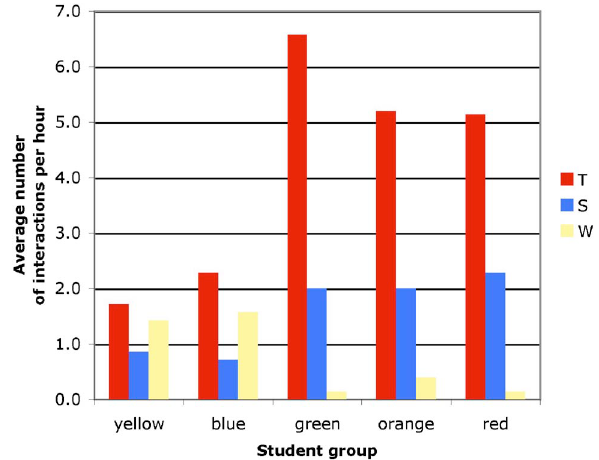
FIG. 2. (cid:1) Color (cid:2) Average number of interactions of each type that each student group experienced per hour of tutorial.